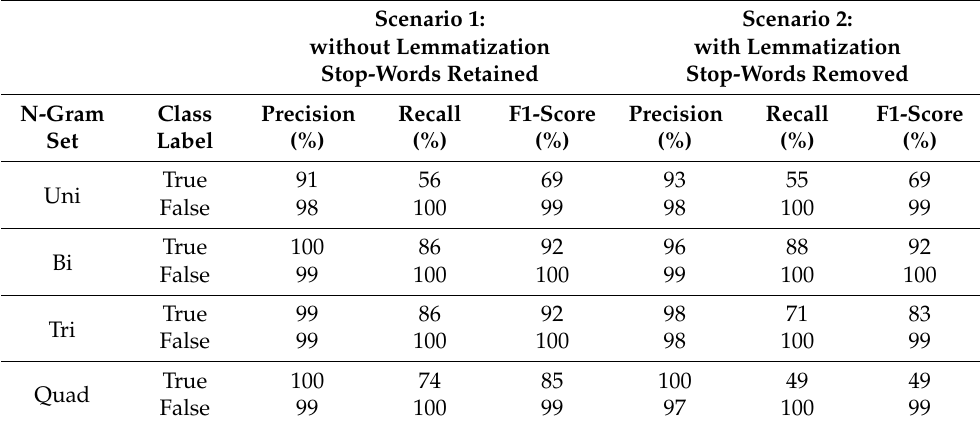
Table 2. Effect of n-gram sets and data pre-processing on performance of rule-based classification for two experimental